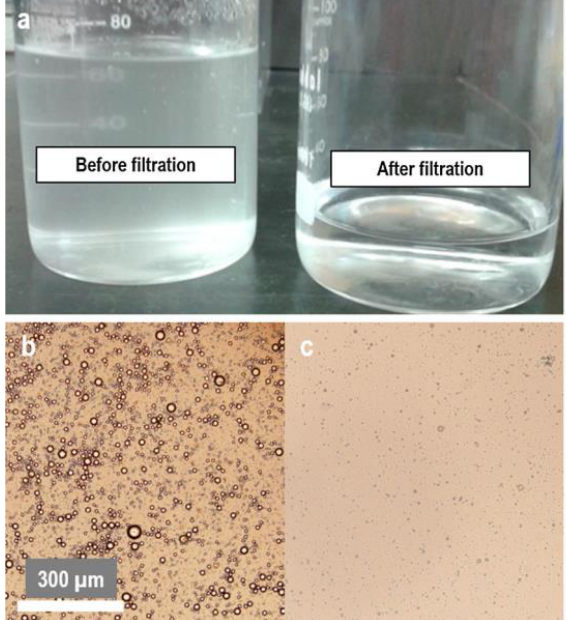
Figure 1. ( a ) Photo of an oil/water emulsion; ( b ) Optical microscopy image of an oil/water emulsion before filtration. ( c ) Optical microscopy image of an oil/water emulsion after filtration. Adapted by permission from Springer Nature: Springer, Cellulose, All-cellulose composite membranes for oil microdroplet collection, Ana P. C. Almeida, Jo ã o Oliveira, Susete N. Fernandes, Maria H.